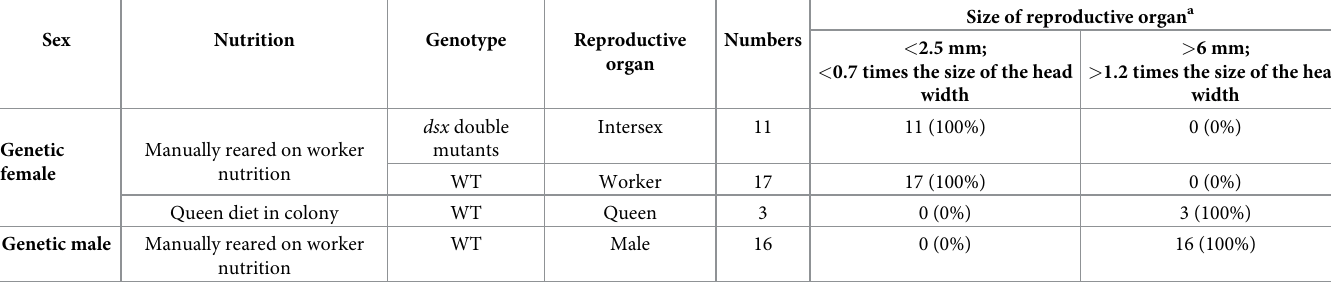
Table 2. The size of the intersex reproductive organs in genetic females double mutant for dsx and reared on worker nutrition. Sex Nutrition Genotype